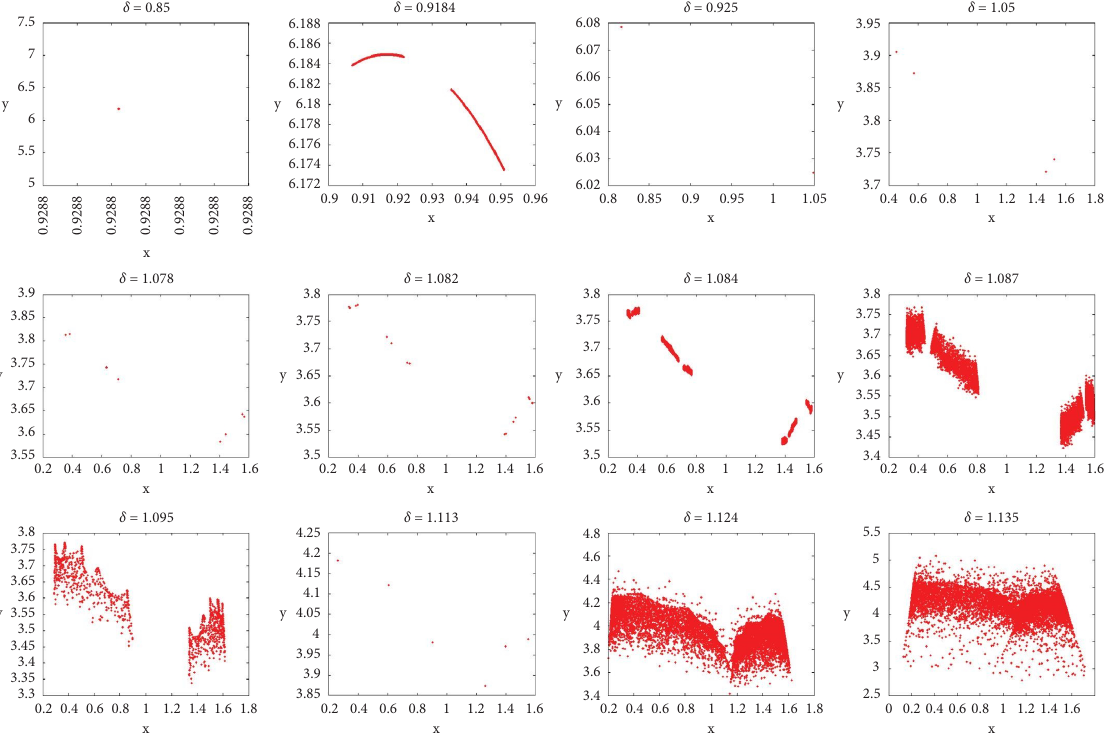
Figure 3: Phase portraits (in xy - plane) for diferent values of δ associated with Figures 2(a) and 2(b).